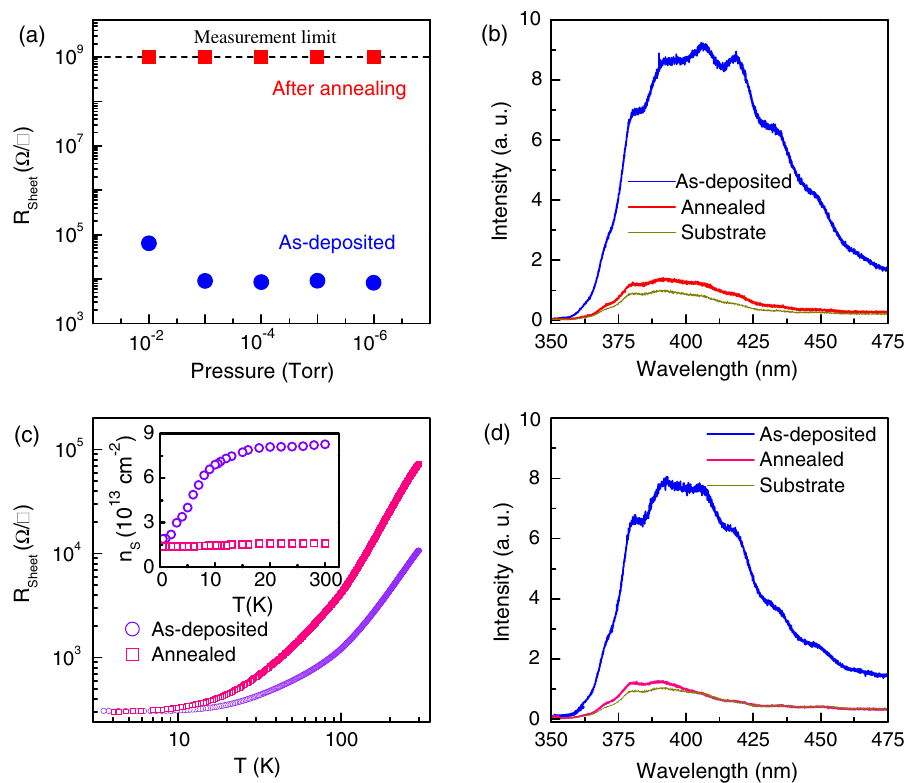
FIG. 4. Oxygen-annealing effect. (a) Room-temperature sheet resistance of 20-nm amorphous LAO/STO heterostructures prepared at different oxygen pressures before and after oxygen annealing in 1 bar of oxygen gas flow at 600 (cid:1) C for 1 h. (b) PL intensity of the 20-nm amorphous LAO/STO heterostructures fabricated at 10 (cid:2) 6 Torr before and after oxygen annealing. (c) R s - T (inset, n s - T ) and (d) PL spectra of a 10-uc crystalline LAO/STO heterostructure prepared at 10 (cid:2) 3 Torr and 750 (cid:1) C before and after oxygen annealing in 1 bar of oxygen gas flow at 600 (cid:1) C for 1